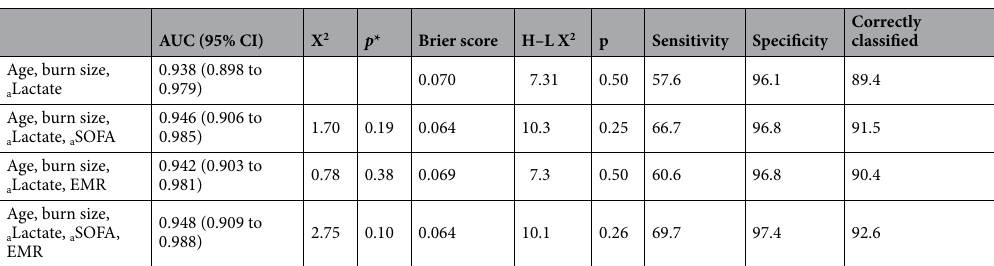
Table 3. ROC-AUC for mortality and pairwise comparison to the model with age, burn size, and lactate. *Pairwise comparison to the first model, no correction, n = 188. SOFA, Sequential organ failure assessment score. EMR, Estimated mortality risk. H–L, Hosmer–Lemeshow